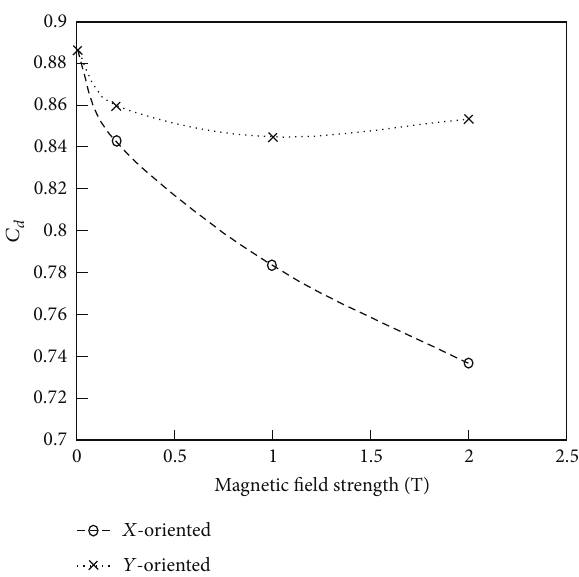
Figure 17: Comparison of drag coefficient for both 𝑋 - and 𝑌 -oriented magnetic